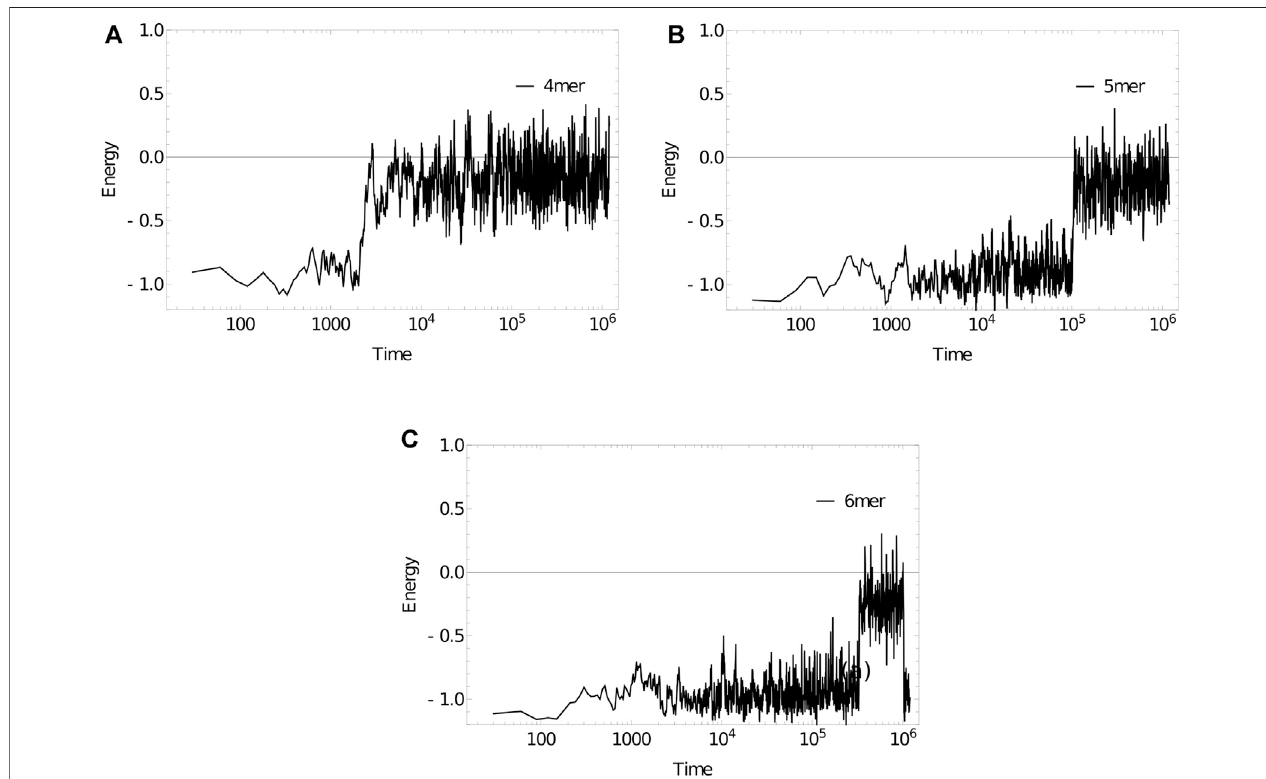
FIGURE 11 | Energy per nucleotide vs simulation time step for (a) 4mer, (b) 5mer, (c) 6mer duplexes at 320 K. Sudden transitions from low to high energy are indicative of rare-event melting.